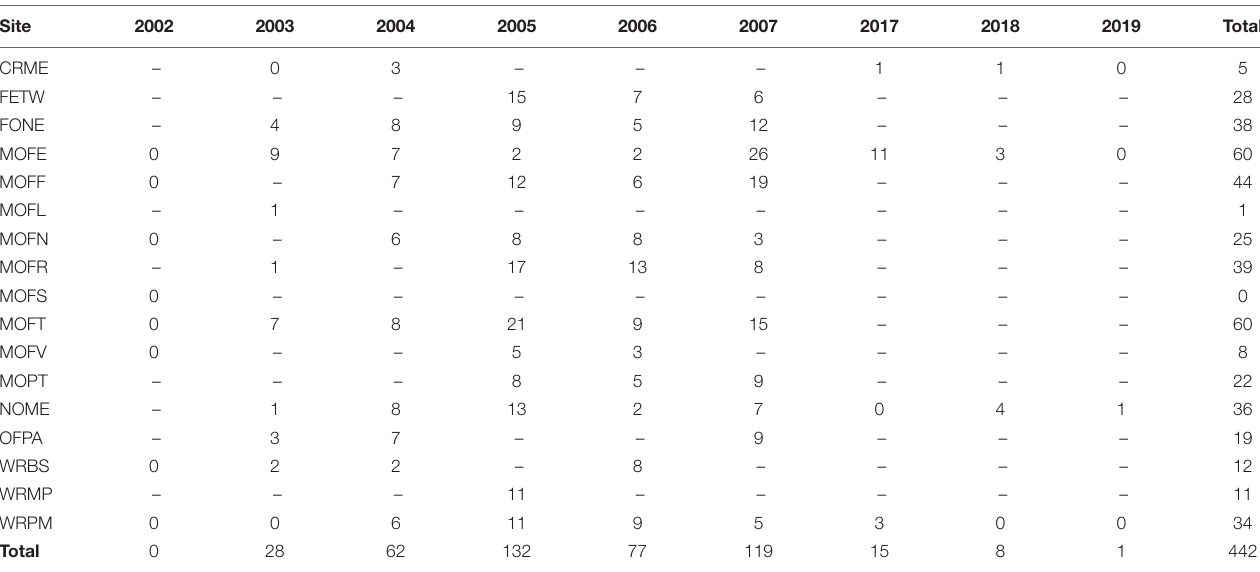
TABLE 7 | Adult cowbird captures by site and